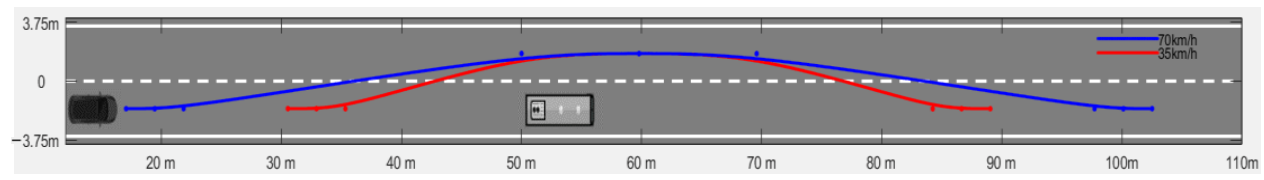
Figure 5. The vehicle has a constant speed of 35 km/h and 70 km/h to avoid small stationary obstacles.